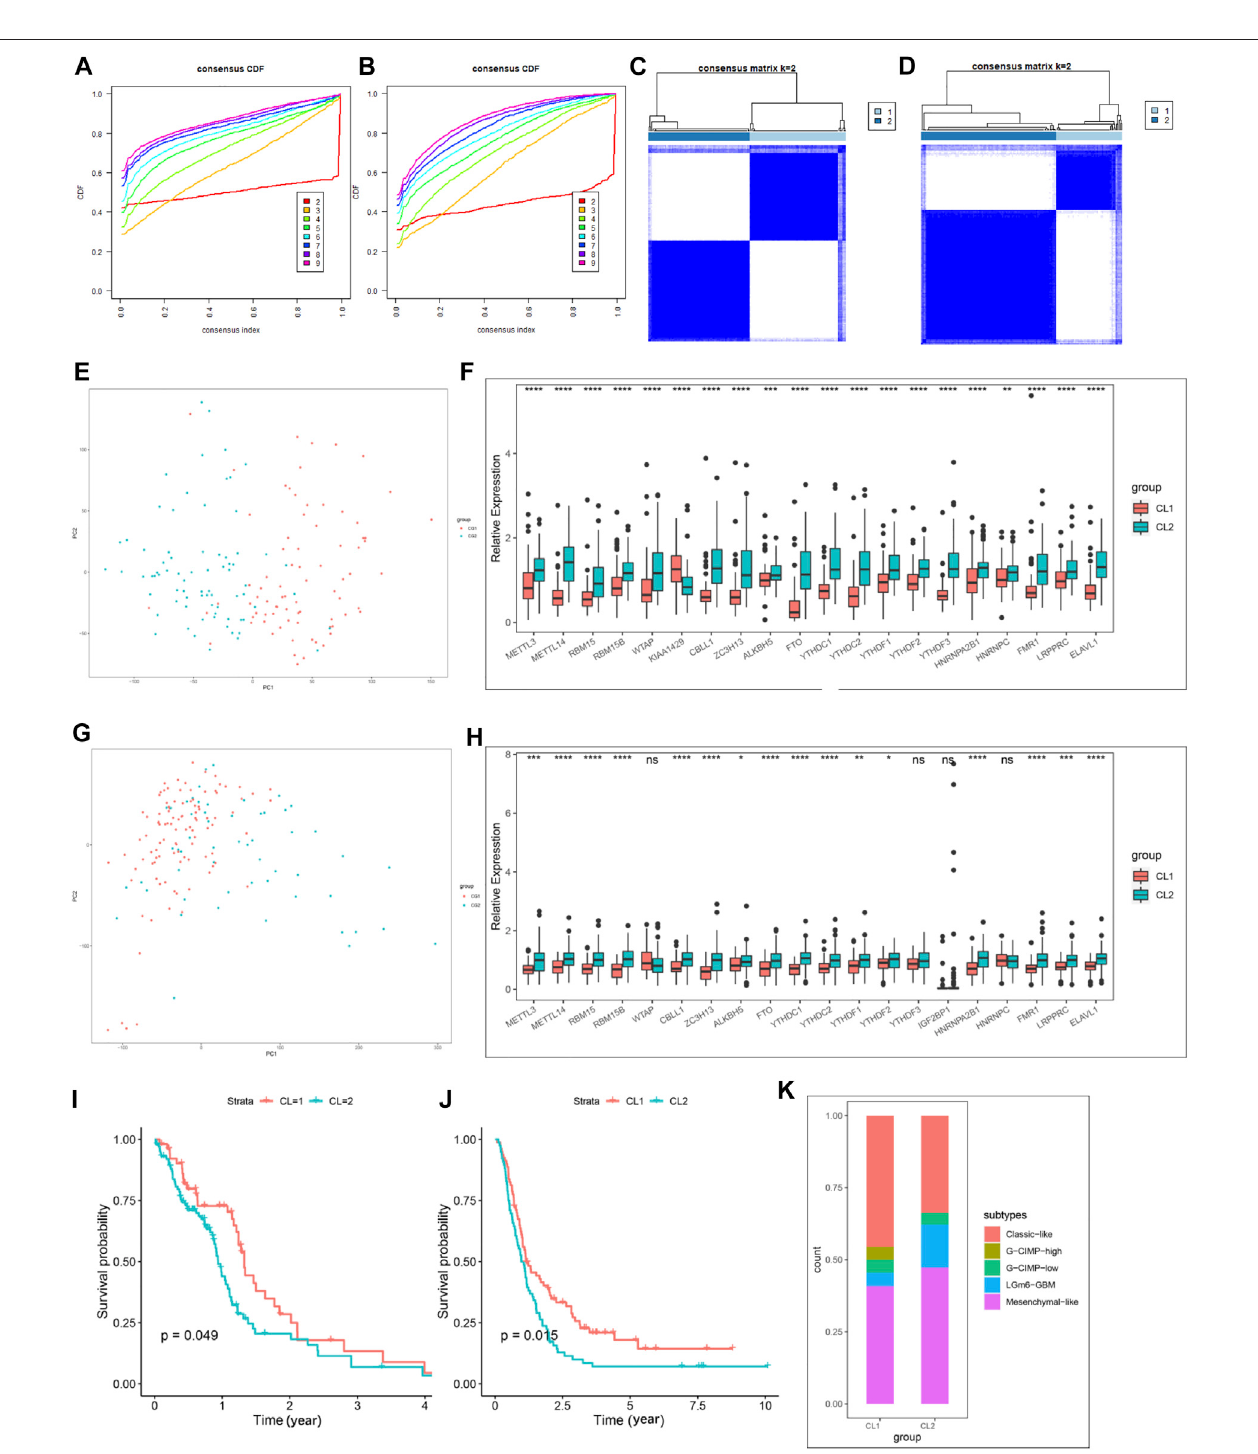
FIGURE2| DifferentialclinicopathologicalcharacteristicsandoverallsurvivalofGBMintheCL1/2subgroup. (A) ConsensusclusteringCDFfork=2 – 10inCGGA- GBM cohort. (B) Consensus clustering CDF for k = 2 – 10 in TCGA-GBM cohort. (C) Consensus clustering matrix for k = 2 in the CGGA-GBM cohort. (D) Consensus clusteringmatrixfork=2intheTCGA-GBMcohort. (E) PrincipalcomponentanalysisofthetotalmRNAexpressionpro fi leintheCGGA-GBMcohort. (F) Theexpression of 21 m6A regulators between the CL1 and CL2 groups in the CGGA-GBM cohort. (G) Principal component analysis of the total mRNA expression pro fi le in the TCGA-GBM cohort. GBM patients in the CL1 subgroup are marked with red, GBM patients in CL2 are marked with blue. (H) The expression of 21 m6A regulators between the CL1 and CL2 groups in the TCGA-GBM cohort. (I) Kaplan – Meier overall survival curves for different CL1 and CL2 groups in TCGA-GBM cohort. (J) Kaplan – Meier overall survivalcurvesfordifferentCL1 and CL2 groups in CGGA-GBM cohort. (K) TheproportionsofDNA methylation subtypes identi fi ed bysupervised clustering in the CL1 or CL2 groups. The upper and lower ends of the boxes represented an interquartile range of values. The lines in the boxes represented the median value, and the dots showed outliers. The asterisks represented the statistical p -value (* p < 0.05; ** p < 0.01; *** p < 0.001, ns, no signi fi cant).